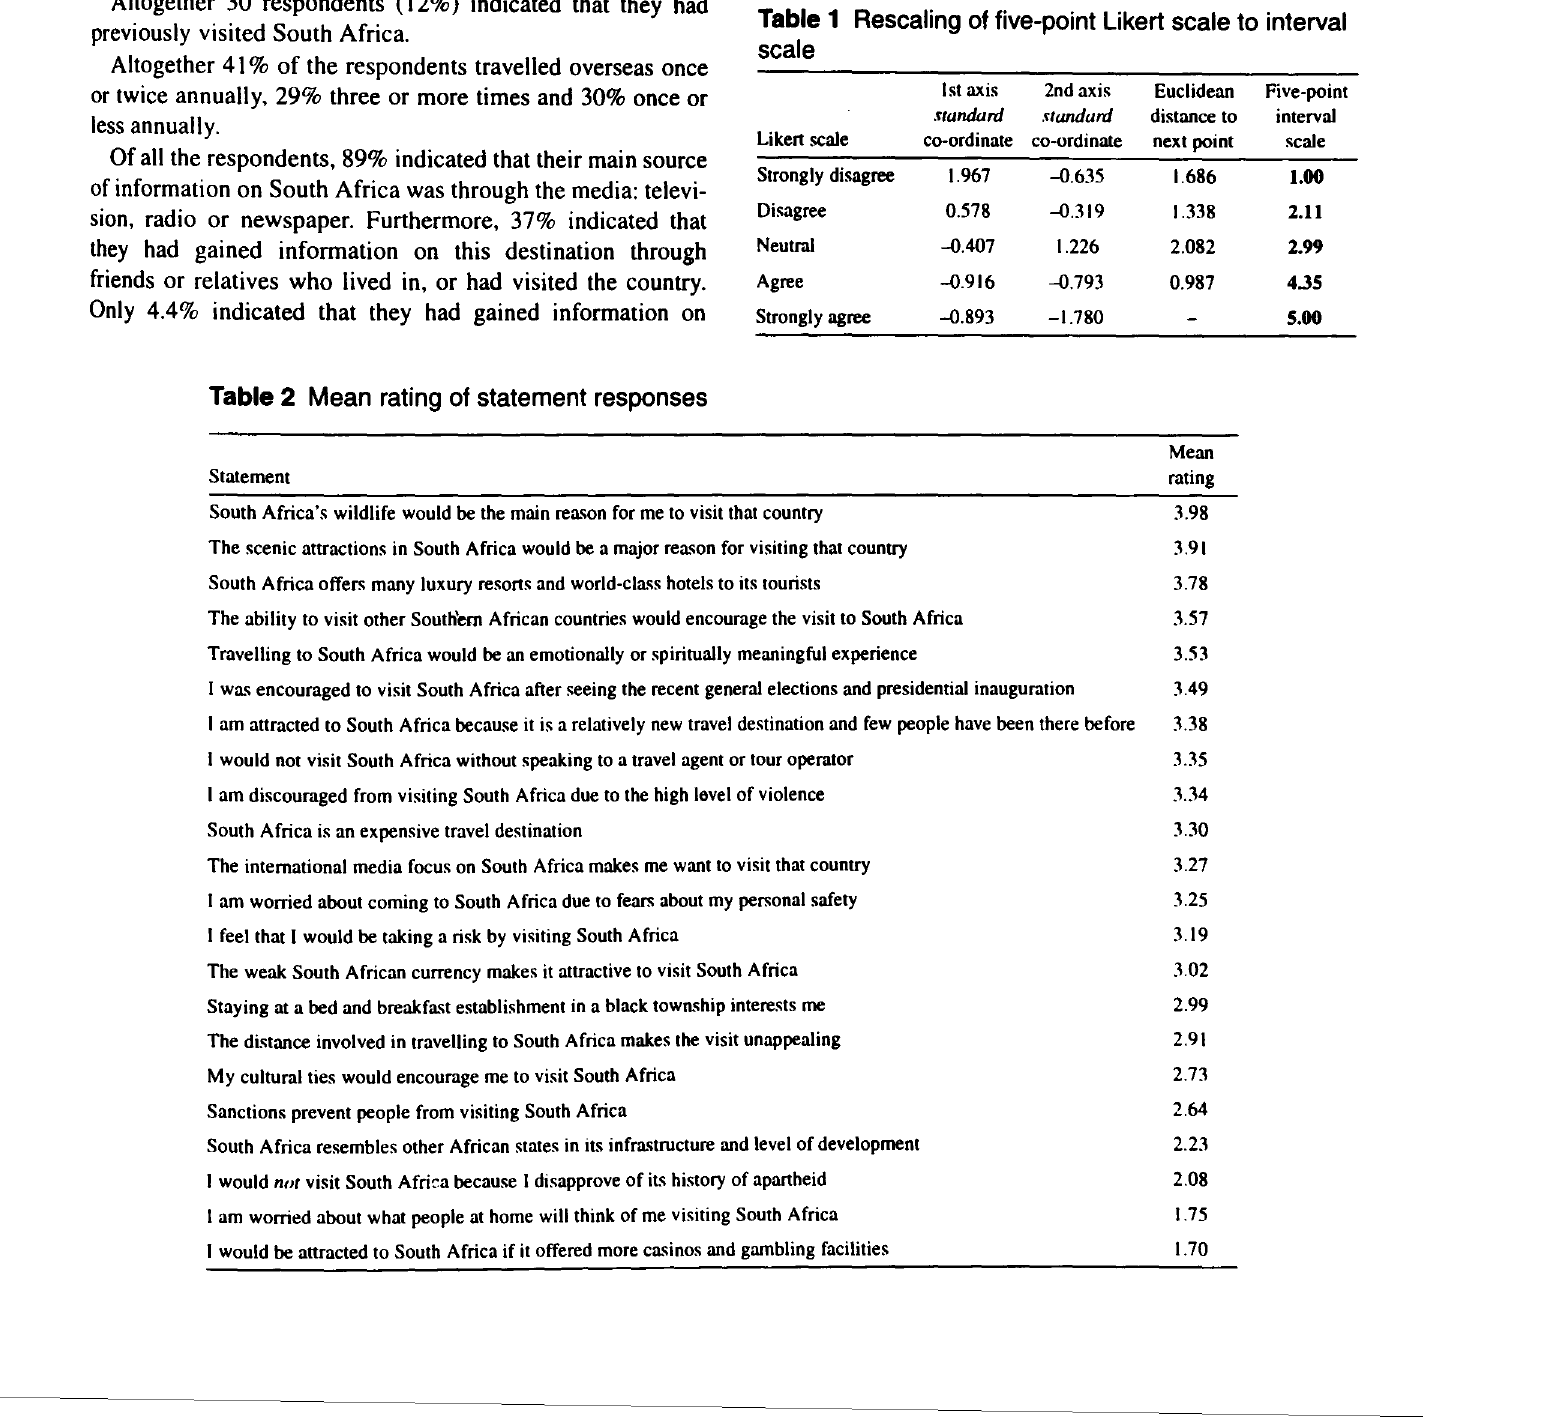
Table 2 Mean rating of statement